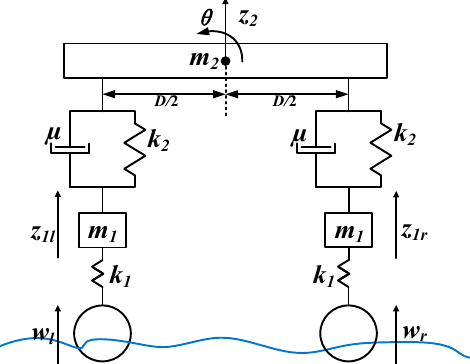
Figure 3. Articulated structure of multi-degree of freedom.